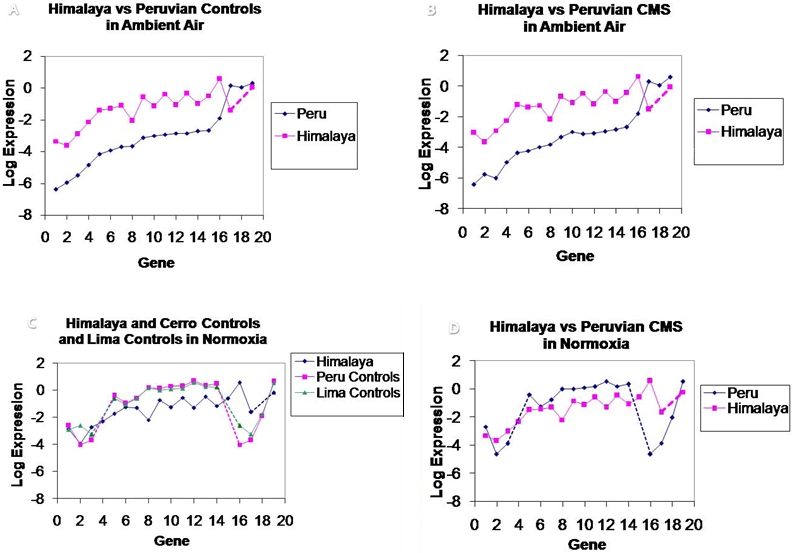
Quantitative comparisons of gene expression in Andean and Himalayan altitude dwellers.A. Controls in Peru altitude 4338 m. and Himalyan controls, on the Tibetan plateau in Ladakh, India, altitude 4450 m. B. CMS patients at the same altitudes as in A in Peru and in the Himalayas. C. Peruvian and Himalayan controls in normoxia. D. Peruvian and Himalayan CMS patients in normoxia. The genes compared in the 2 populations are: 1 = HIF-1a; 2 = HPH3; 3 = HIF-3a; 4 = VEGFC; 5 = PDK4; 6 = HIF2a; 7 = PDP2; 8 = PDK1; 9 = PDHE1a1; 10 = EPOR; 11 = PDP1; 12 = PDK3; 13 = HIF1b; 14 = PDK2; 15 = GLUT1; 16 = GAPDH; 17 = HPH1; 18 = EPO; 19 = HPH2. Interrupted lines span across genes not assayed. In ambient hypoxia all Himalayans (controls and CMS) had significantly higher gene expression when compared to Andeans except for HPH1. The differences between the groups, while normoxic, were not significant. (C. D.).